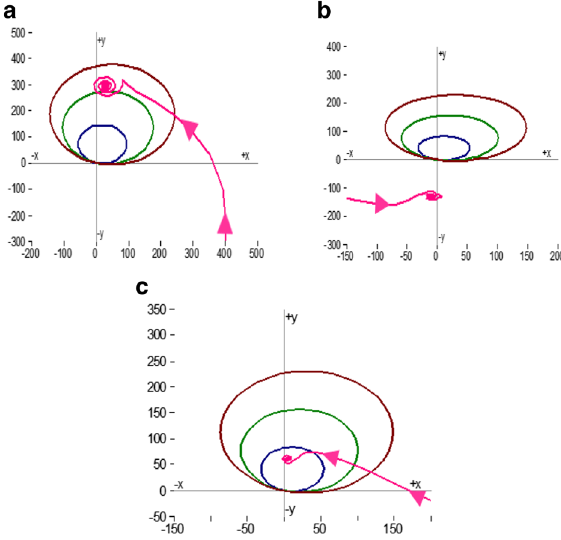
Fig. 8 Performance of ( a ) R 12 , ( b ) R 21 & ( c ) R 23 for LL (RY) fault at 550 km from Bus-1 (i.e. 200 km from Bus-2) with the proposed methodology